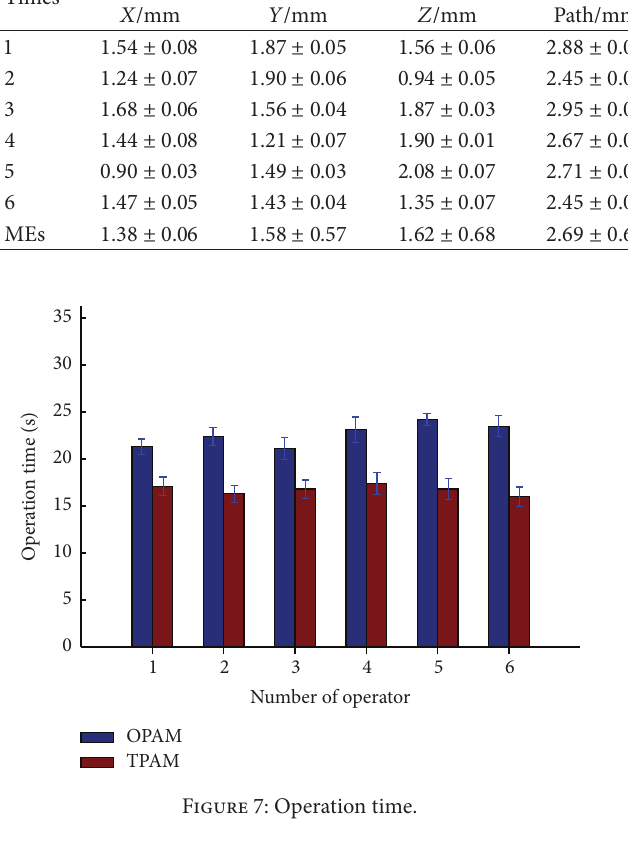
Table 4: Mean absolute errors (MAEs) for 6 tests measured by the robot in the period of inserting. Times